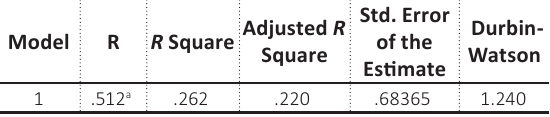
Table 2. Explanation level of the model